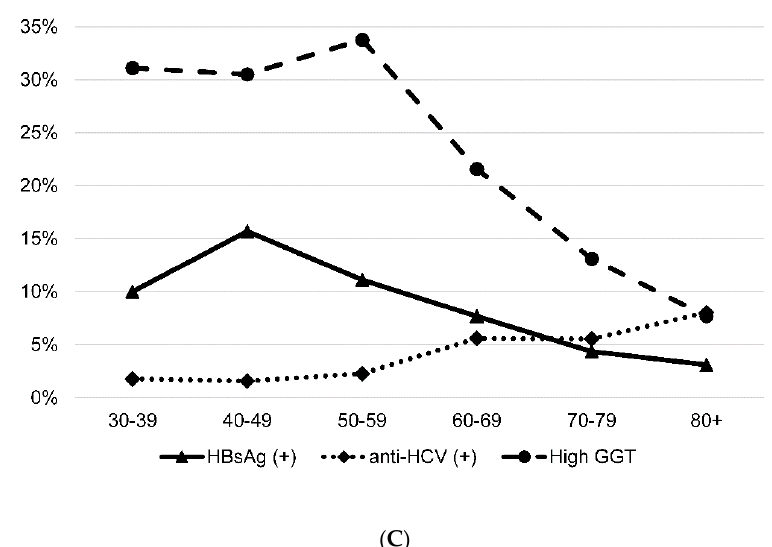
Figure 2. Age ‐ specific prevalence of hepatitis B surface antigen (HBsAg), antibody to hepatitis C virus (anti ‐ HCV) and high gamma ‐ glutamyl transferase (GGT). ( A ) Total screening of residents in both communities, ( B ) Laiyi township and ( C ) Mudan township. Table 2. Screen coverage rate and prevalence of hepatitis B virus surface antigen (HBsAg), antibody to hepatitis C virus (anti ‐ HCV) and high gamma ‐ glutamyl transferase (GGT) stratified by gender and village.